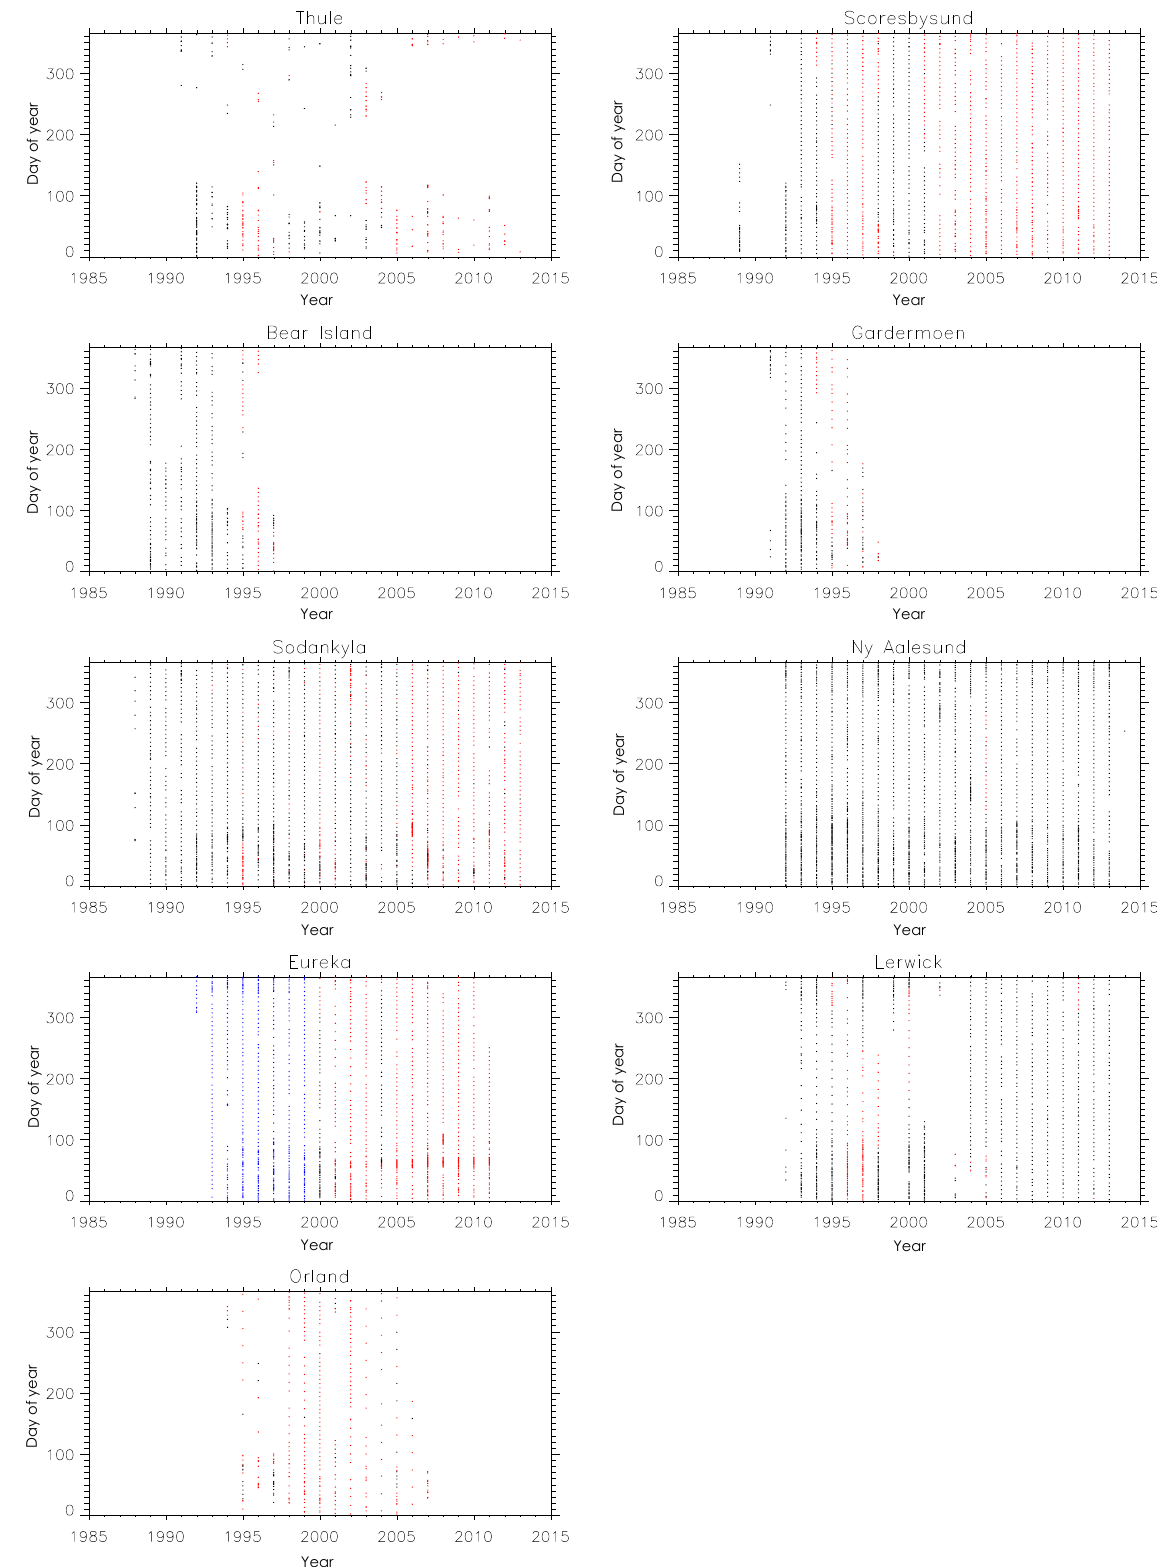
Figure 2. Timing of soundings. Each dot represents a sounding reaching at least 250hPa. Red dots indicate EnSci type sondes and black dots Science Pump sondes. Blue dots indicate that the type is not reported in the